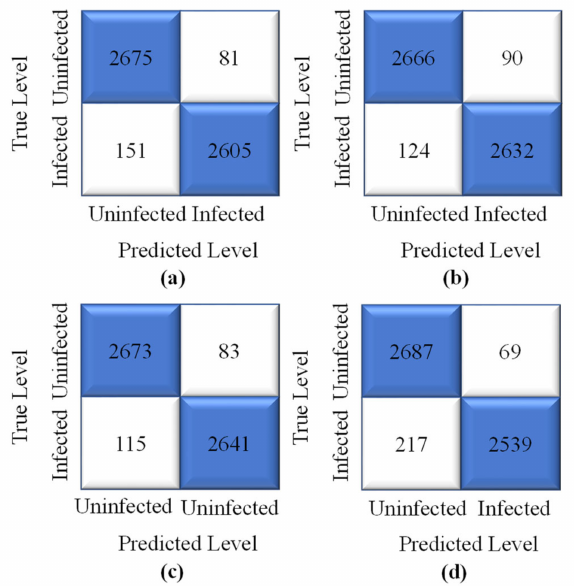
Figure 9. Confusion matrix of the proposed model obtained with original dataset, SGD optimizer, and batch sizes of ( a ) 8 ( b ) 16 ( c ) 32, and ( d ) 64.